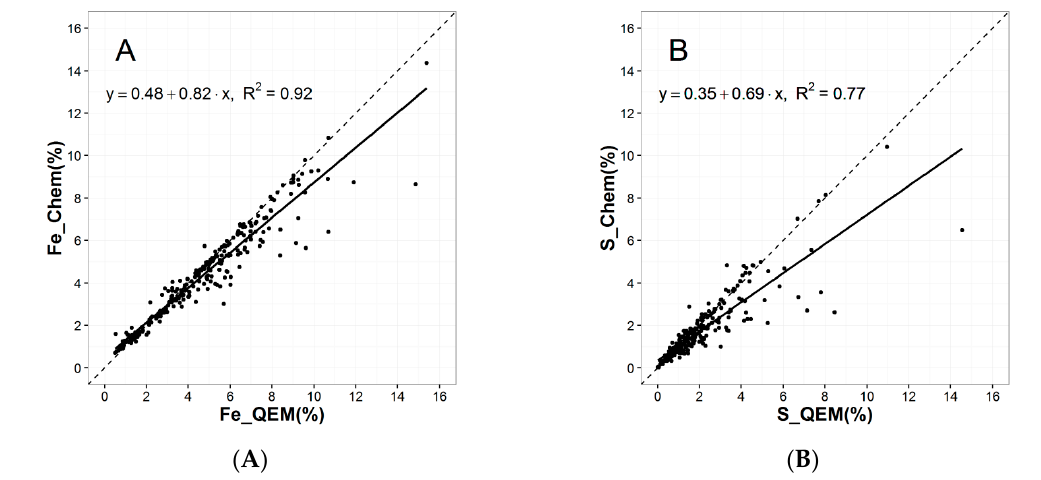
Figure 1. Scatter plots comparing chemical assays for Fe ( A ) and S ( B ) versus percentages calculated using QEMSCAN ® mineralogy. The assays were done by atomic absorption spectroscopy and LECO ® (LECO Corporation, Saint Joseph, MI, USA) for Fe and S, respectively. Dotted lines represent the 1:1 correlation line, whereas solid lines are linear regression fits.